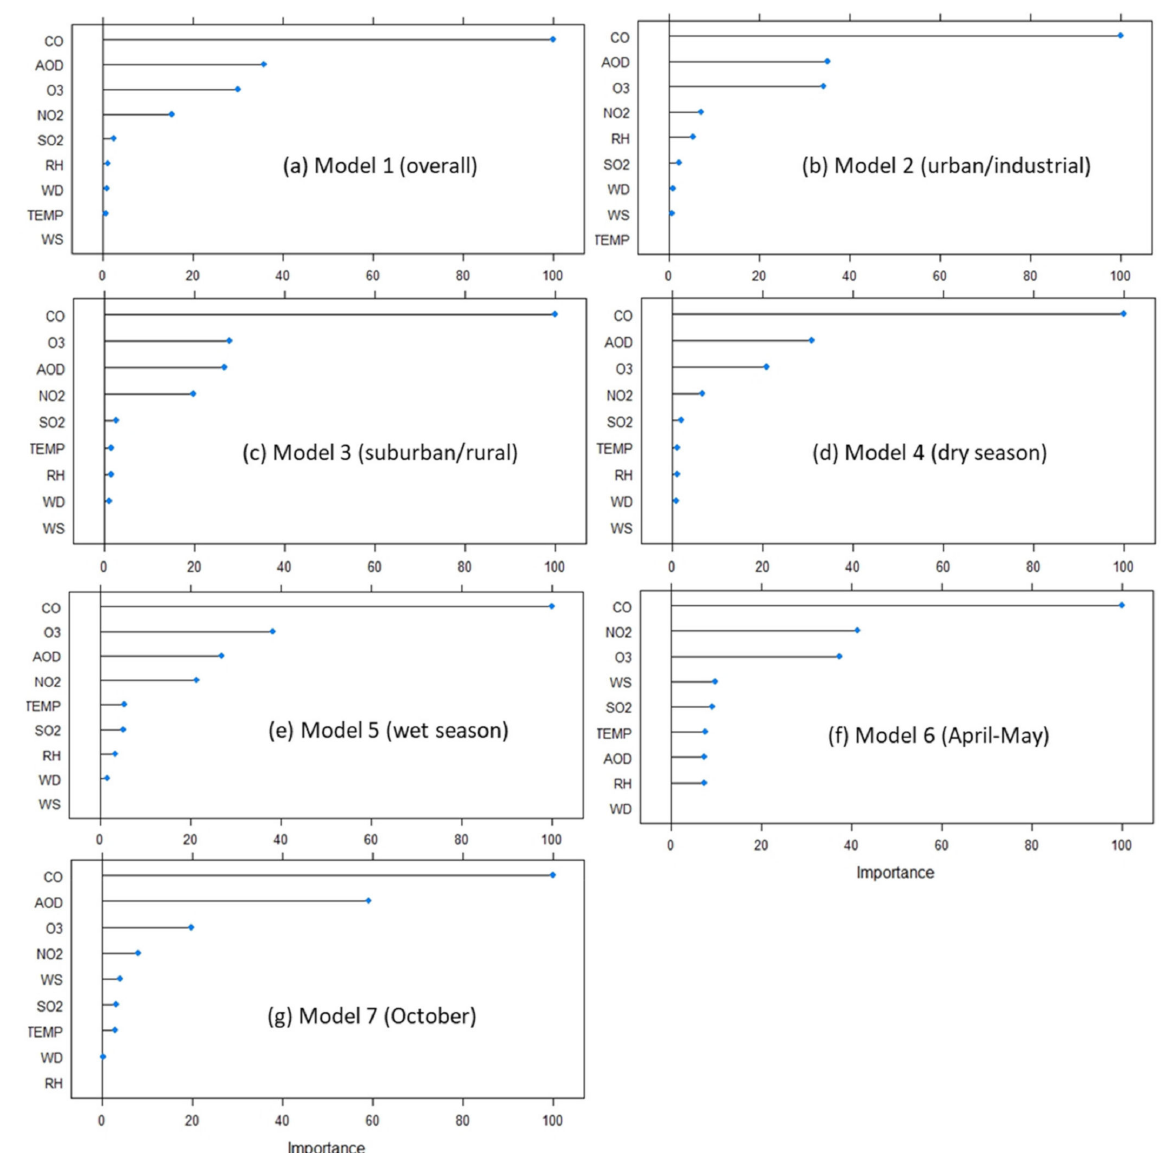
Figure 7. Variable importance analysis for the RF Models 1–7 ( a – g ). Y-axis indicates the predictor for PM 2.5 estimations, and x-axis indicates the importance scores between 0 and